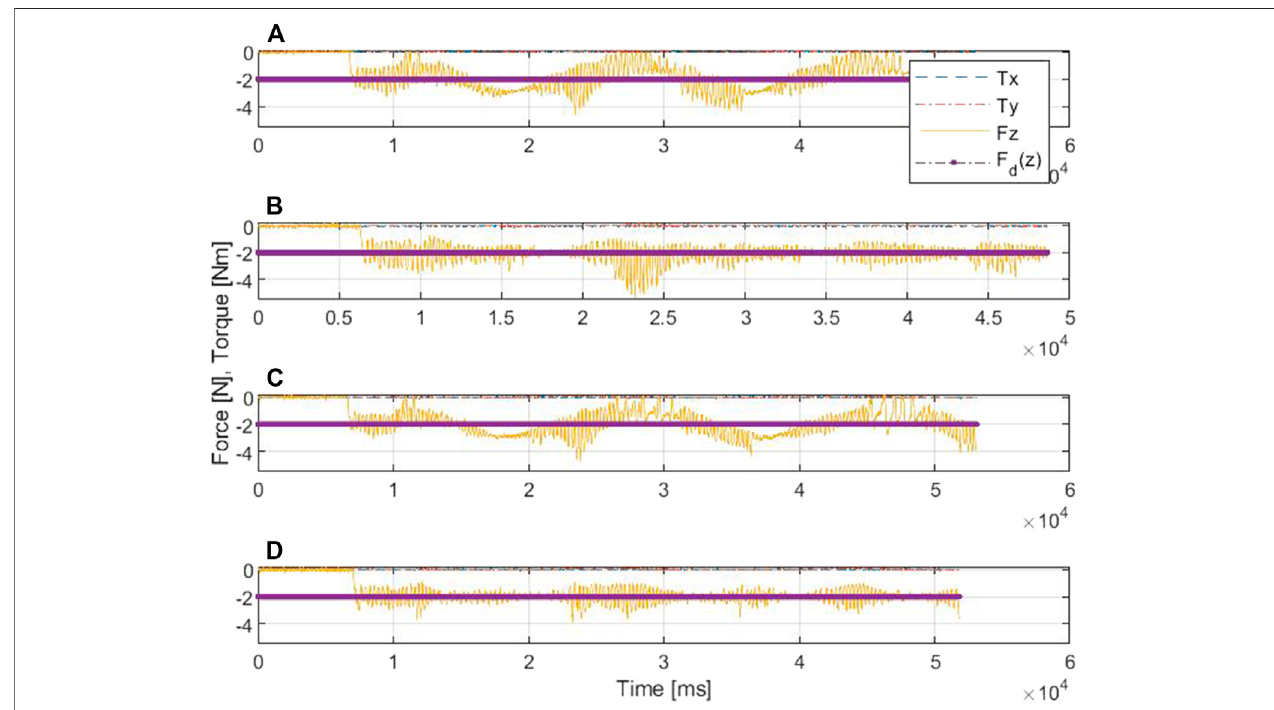
FIGURE 10 | Comparative results of the force/torque measurements in scenario I: (A) is for AC, (B) is for DAC, (C) is for SAC, and (D) is for SDAAC.